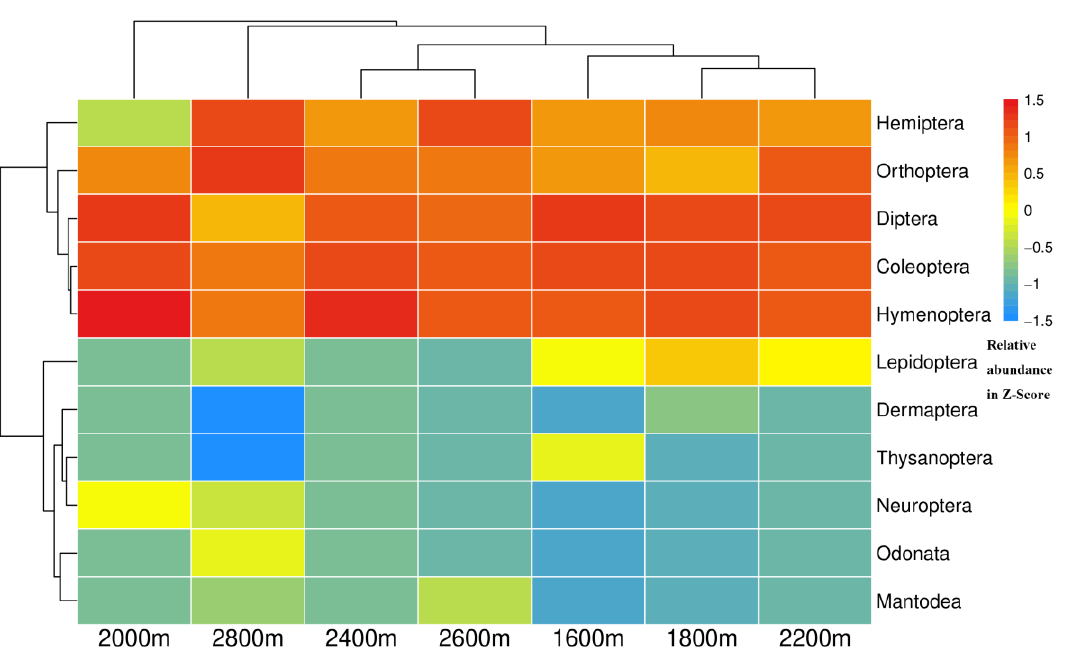
Figure 4. The difference in insect composition in typical vegetation community ecosystems along altitudinal gradient of the Guandi Mountain. ( A ): Orders; ( B ): Families; ( C ): Species; ( D ): Individuals. Note: Values are mean ± SD of three replicates for each typical vegetation community ecosystem. For each column, values with different letters are significantly different at p = 0.05.